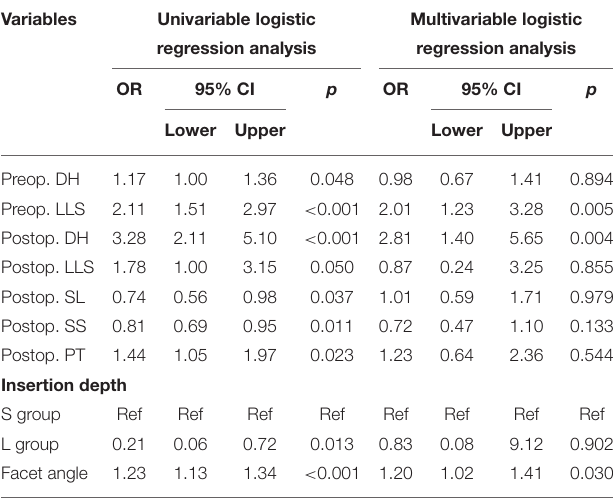
TABLE 4 | Univariate and multivariate logistic regression analysis of unfavorable clinical outcomes in the short-term cohort. Variables Univariable logistic